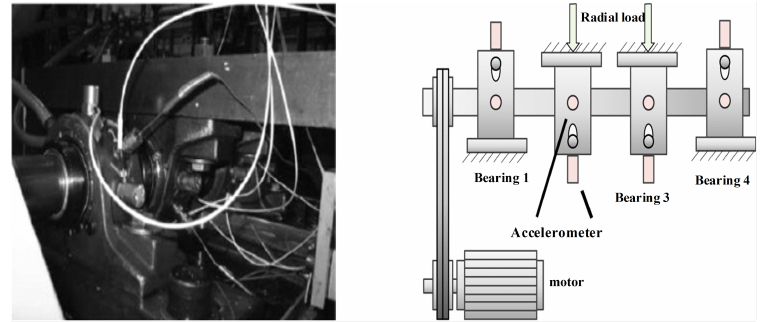
Figure 5. The bearing accelerated life test bench.